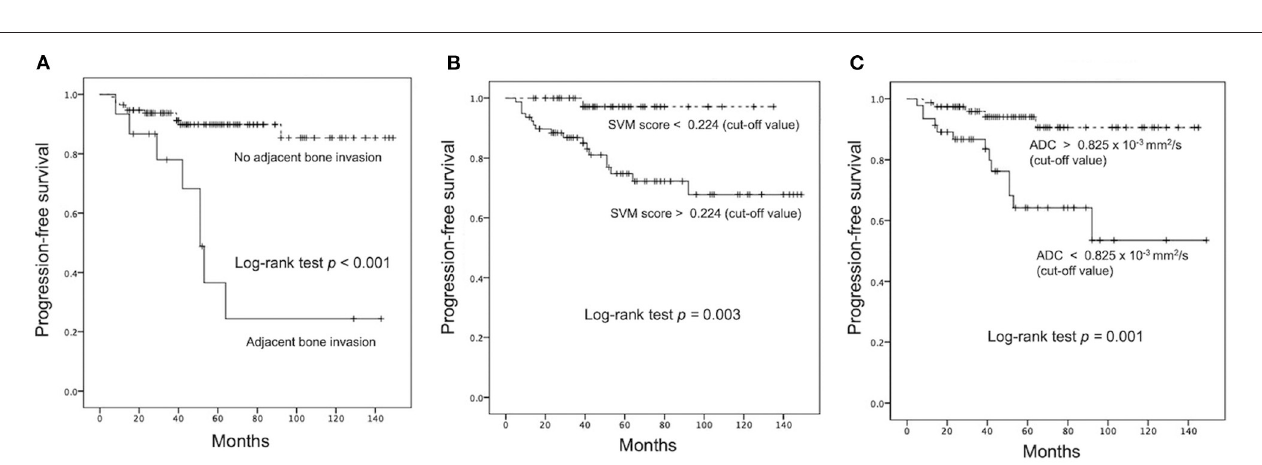
FIGURE 5 | Kaplan–Meier survival curves of (A) adjacent bone invasion, (B) SVM score, and (C) ADC value for the prediction of P/R in meningiomas. All three parameters showed significant difference ( p < 0.05) (log-rank test) in overall trend of progression-free